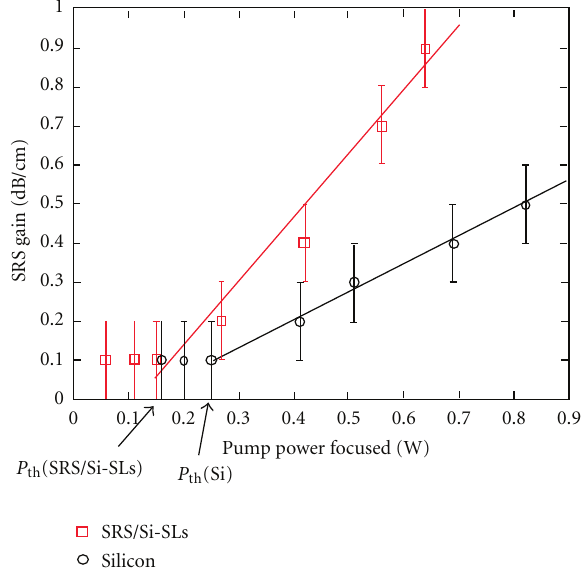
Figure 3: The SRS gain (amplification of the stokes signal in dB/cm) is plotted against the e ff ective pump power at the sample surface both for SRN/Si-SLs ( (cid:2) red) and for bulk silicon ( (cid:4) black).